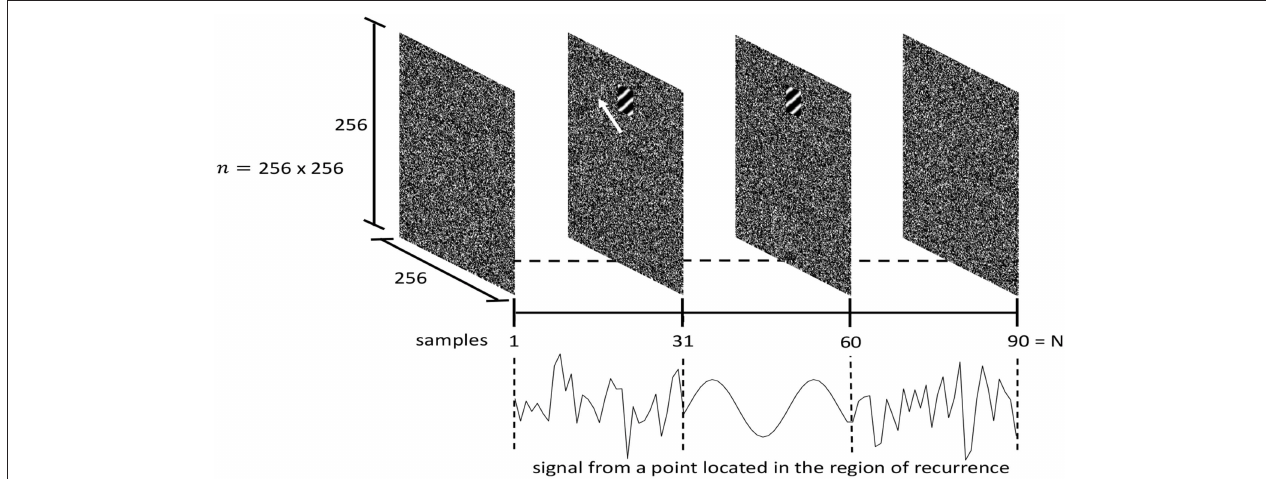
FIGURE 2 | Example of spatio-temporally localized recurrence. A 2D sinusoidal wave of limited time duration appears in a specific region of a random noise image, and propagates in the direction indicated by the white arrow. The sequence consists of N 90 frames, with the sine wave appearing at frame 31 and lasting for 30 = frames until frame 60. The frame size is 256 256 points, while the region of recurrence has size 32 32. At the bottom, the signal associated with a point (a pixel) in × × the region of recurrence is depicted (90 sample long signal), showing the alternation between random noise and the sine wave. The matrix B corresponding to this case has a size of 65536 90. ×